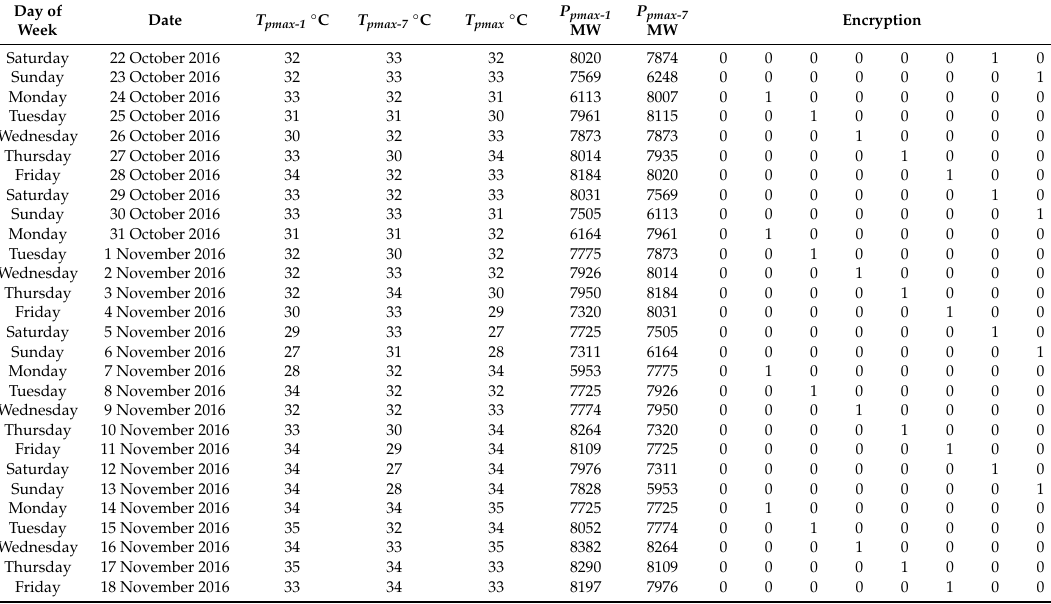
Table 3. The input data for peak load